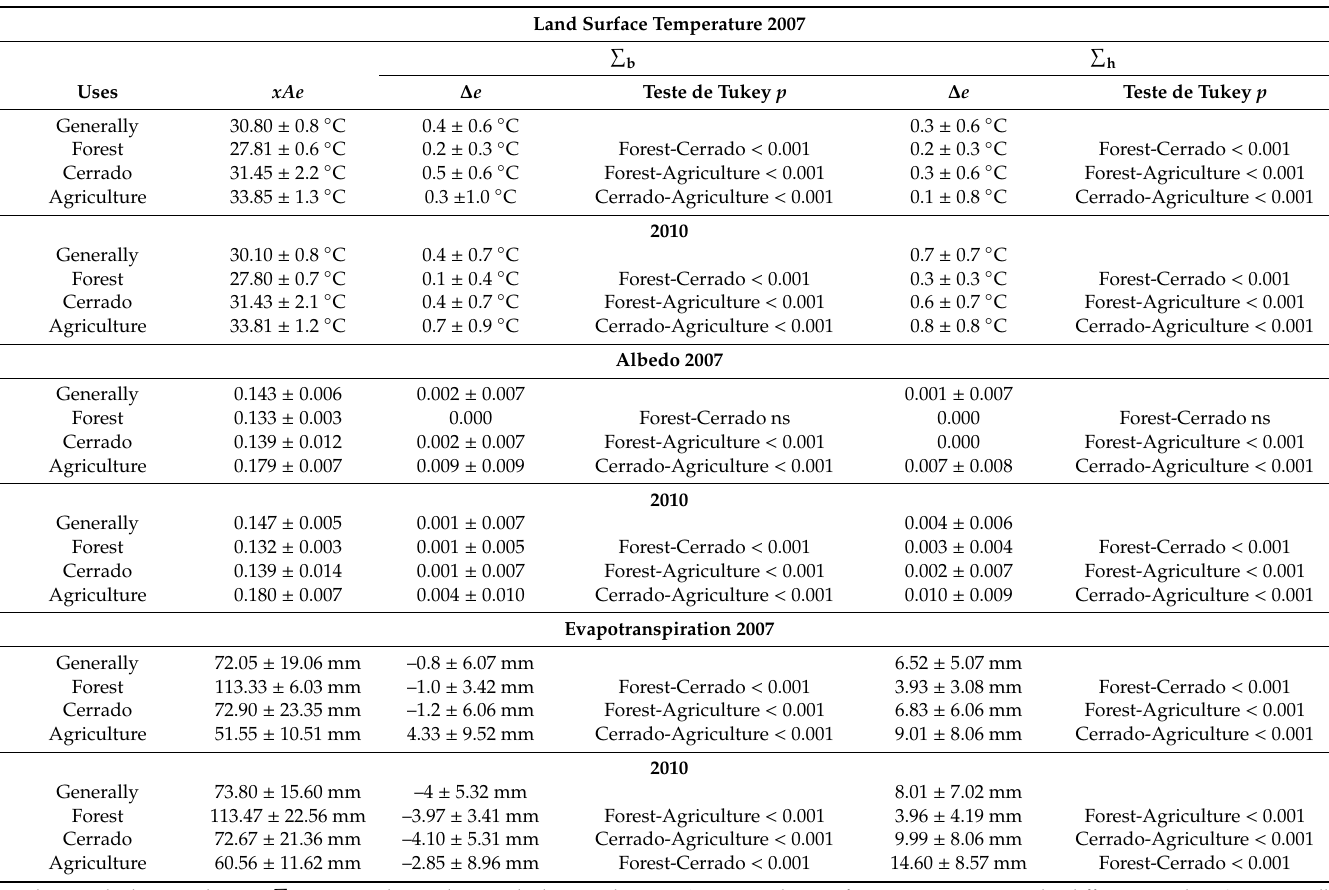
Table A1. Parameters used to evaluate evapotranspiration (ET), land surface temperature (LST), and albedo (in years of severe drought) in the principal types of land cover (forest, savanna, and cropland) in the Brazilian state of Mato